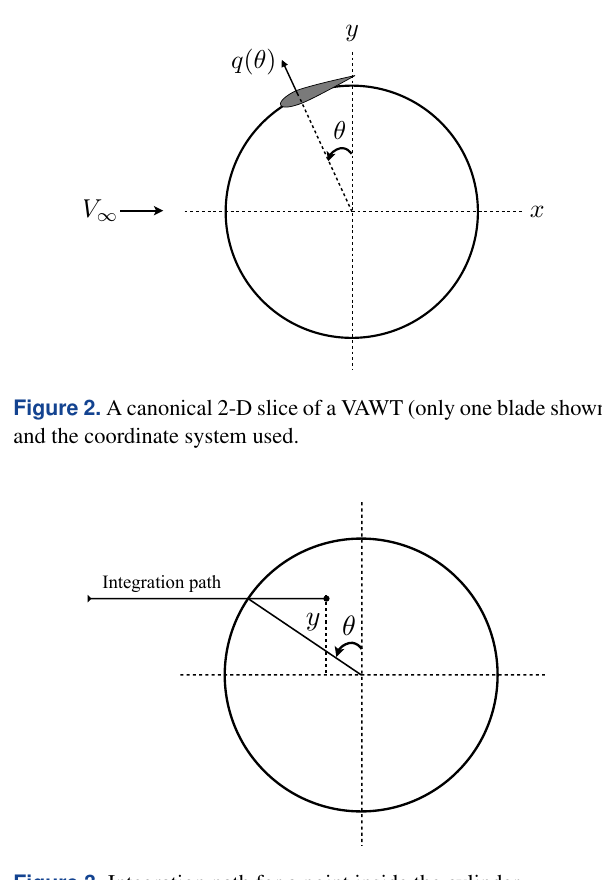
Figure 3. Integration path for a point inside the